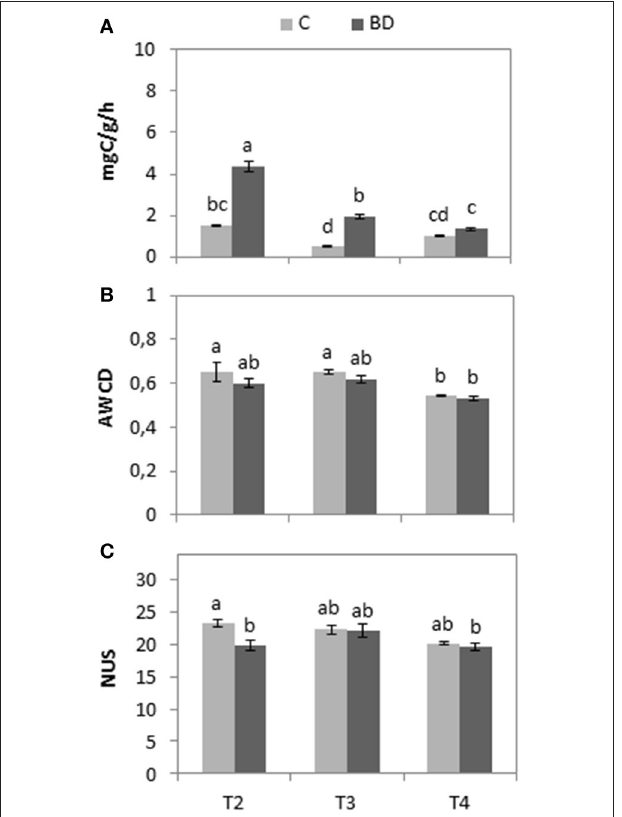
FIGURE 3 | (A) Mean values and standard errors of soil respiration rate (mgC/g/h) in dry matter after 72h incubation time at 30 ◦ C. (B) Mean values and standard errors of average well color development (AWCD). (C) Number of used substrates (NUS) in Biolog Ecoplates TM at half of the incubation time. All values of control (C) and biodisinfested (BD) soils measured at three different times: T2 (post-treatment), T3 (post-crop after treatment) and T4 (1 year after treatment). Values with the same letter are not significantly different among time and treatment combinations according to Tukey HSD test ( P < 0.05).